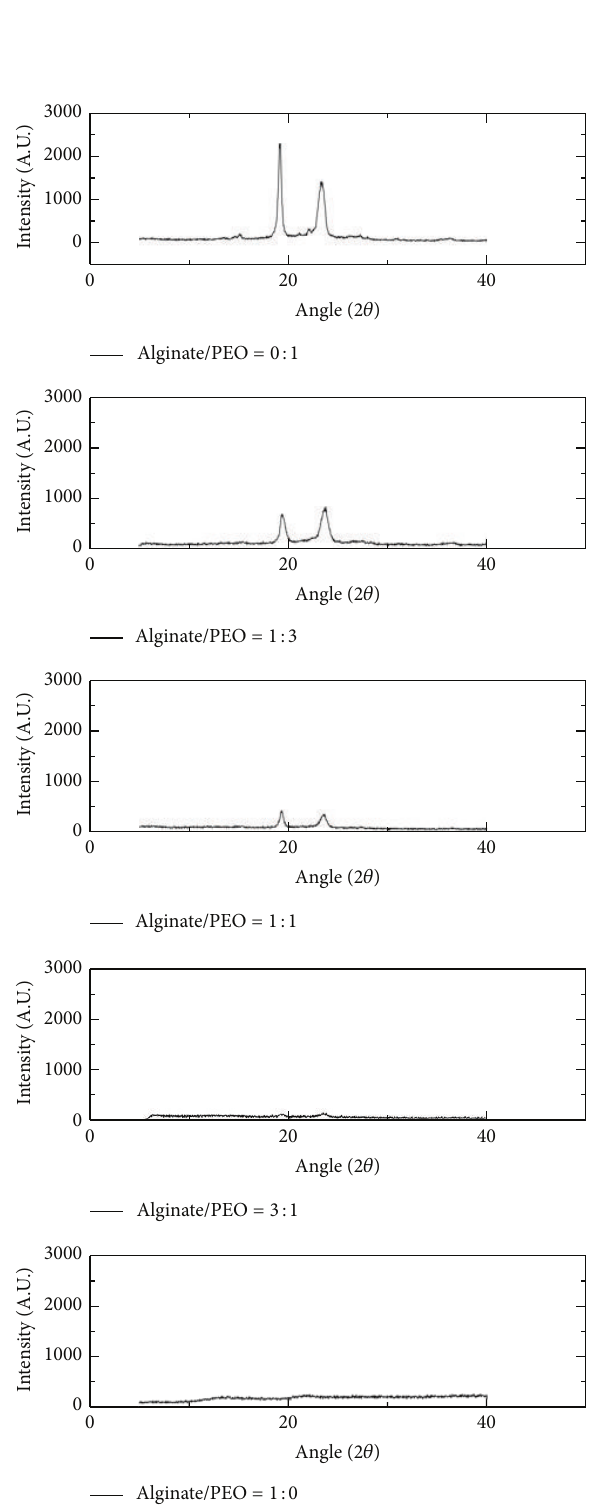
Figure 7: PXRD patterns of electrospun nanofibers from 5% solution concentration with different NaAlg/PEO